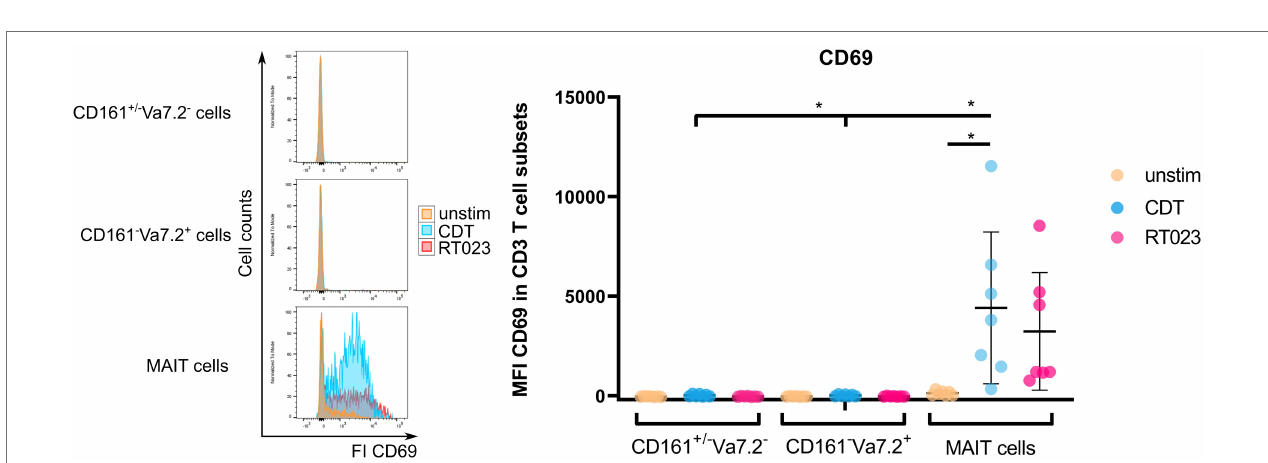
FIGURE 2 | Activation of MAIT cells, CD161 +/ − V α 7.2 − , and CD161 − V α 7.2 + cells following stimulation with C. difficile CDT. PBMCs were isolated from healthy donors and stimulated with 100 ng/ml CDT for 20 h followed by flow cytometric analyses of CD69 surface expression. Cells were gated on either CD161 ++ V α 7.2 + , CD161 +/ − V α 7.2 − or CD161 − V α 7.2 + CD3 + T cells and median fluorescence intensity of CD69 is displayed. Horizontal lines indicate mean ± SD. Asterisks indicate significant differences determined by eight Wilcoxon matched-pairs signed rank tests with Bonferroni Holm correction: * p < 0.05. The following conditions were pairwise compared within all subsets: unstimulated (unstim) vs. CDT or unstim vs. RT023. Additionally, CDT of MAIT cells vs. CDT of CD161 +/ − V α 7.2 − or CD161 − V α 7.2 + were also compared. Data represent five independent experiments from seven